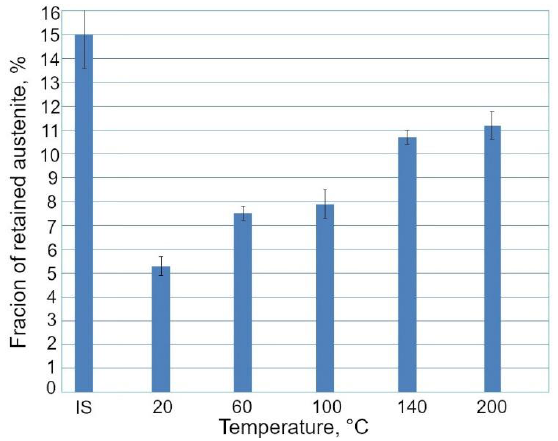
Figure 9. Fraction of retained austenite (RA) in the initial state (IS) and after deformation at different temperatures.